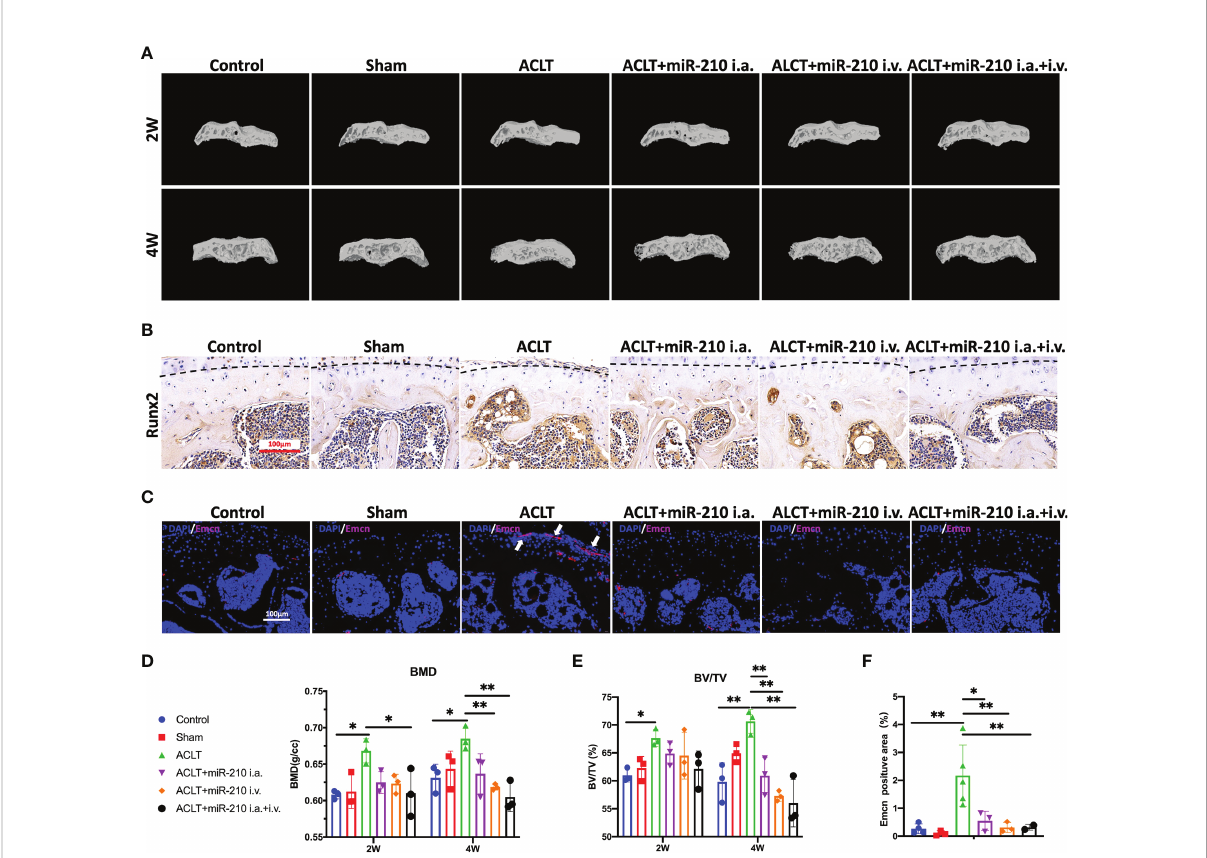
FIGURE 7 OA alleviation by miR-210-3p overexpression is attributable to the inhibition of subchondral angiogenesis. (A) Representative microCT reconstruction images of the tibial plateau of LH knees in each group at 2 weeks and 4 weeks. (B) Representative images of immunohistochemical staining for RUNX2 in subchondral bone of the tibial plateau in each group at 4 weeks. Dotted lines: tidemark. Scale bar: 100 m m. (C) Representative images of immuno fl uorescence staining for Emcn (red) and DAPI (blue) in the tibial plateau of LH knees in each group at 4 weeks. Vessels invading the cartilage are indicated by white arrows. Scale bars: 100 m m. (D, E) Quanti fi cation of the BMD and BV/TV of subchondral bone of the tibial plateau in each group at 2 weeks and 4 weeks. (F) Quanti fi cation of Emcn positive staining area in each group. ** P < 0.01. * P < 0.05. BMD, bone mineral density. BV/TV, bone volume/tissue volume. All data are presented as the means ± standard deviations. Statistical signi fi cance was determined using unpaired, 2-tailed Student ’ s t